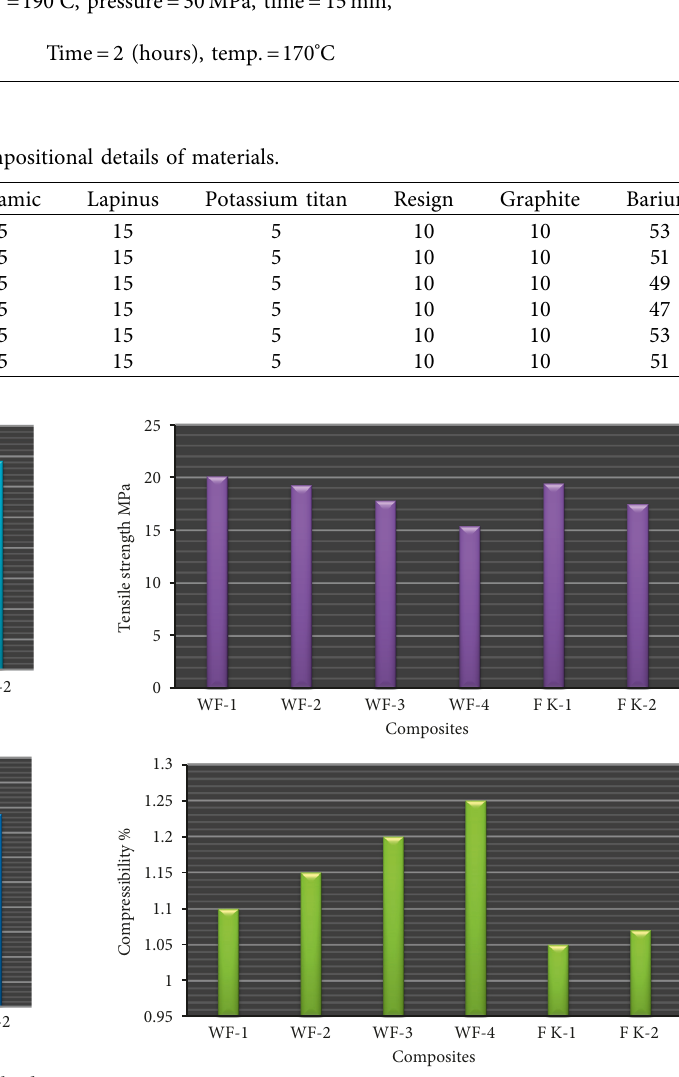
Figure 2: Tensile strength and compressibility of newly developed